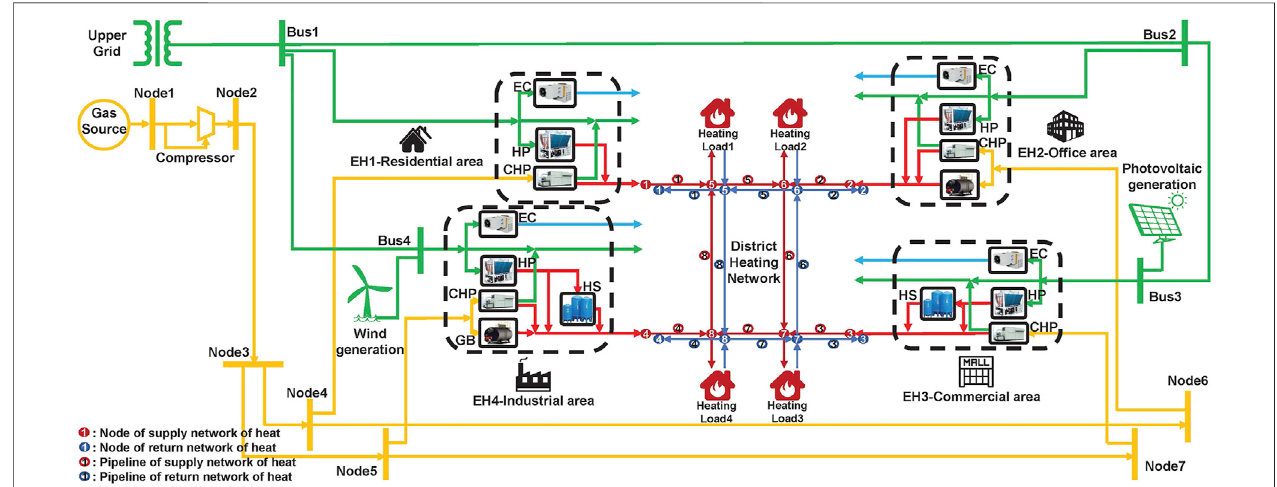
FIGURE 7 | Schematic of the system composed of four networked